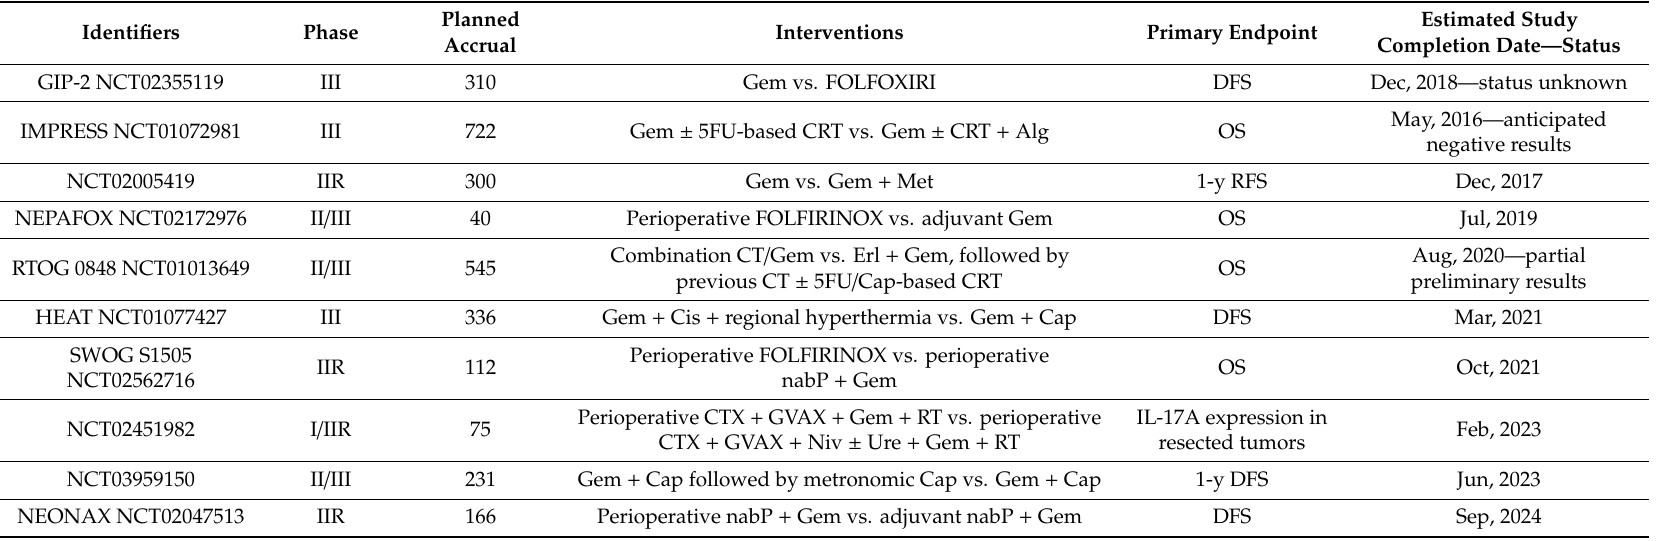
Table 4. Pending results from randomized trials regarding either adjuvant or combined neoadjuvant and adjuvant treatments in resectable pancreatic cancer, as listed on www.clinicaltrials.gov, www.clinicaltrialsregister.eu and www.umin.ac.jp by September